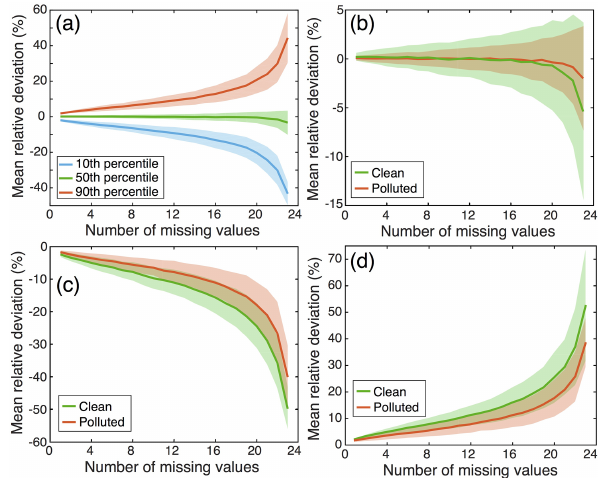
Figure 4. Impacts of the number of missing values on daily aver- ages of PM 2 . 5 . Mean relative deviations were calculated between PM 2 . 5 daily averages estimated from 1000 hourly PM 2 . 5 records with a given number of missing values and the original ones with- out missing values. (a) Deviations at different percentiles in all-sky conditions; (b) deviations at the 50th percentile under different pol- lution scenarios; (c) same as (b) but for the 10th percentile; (d) same as (b) but for the 90th percentile. Thick lines represent mean devia- tions, while shaded regions are uncertainties of 1 standard deviation from the mean.